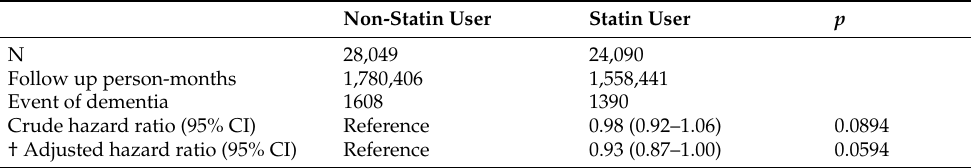
Table 2. The incidence rate of dementia in patients with chronic kidney disease.